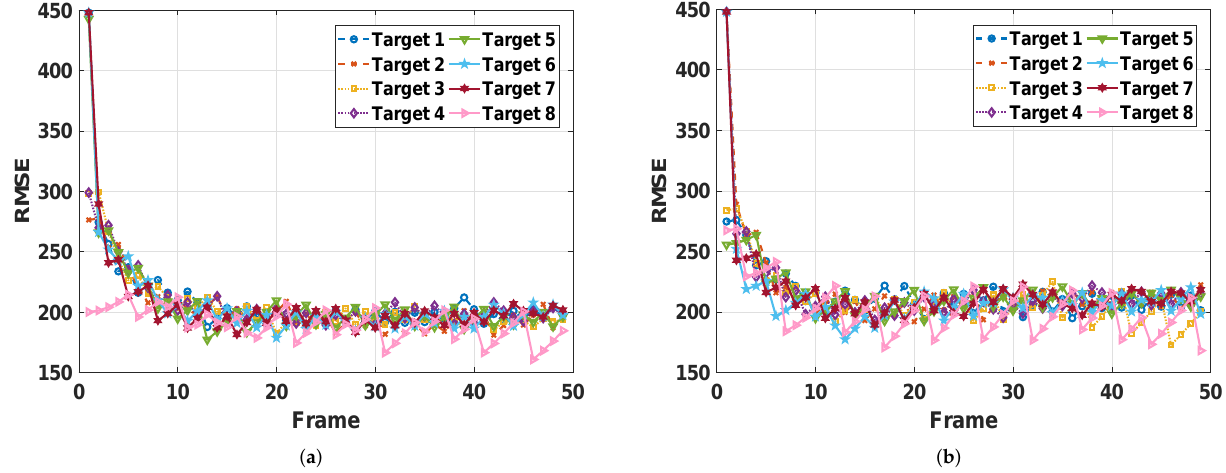
Figure 12. Tracking RMSEs of different targets with given RCS model. ( a ) Proposed power allocation method. ( b ) Optimization-based power allocation